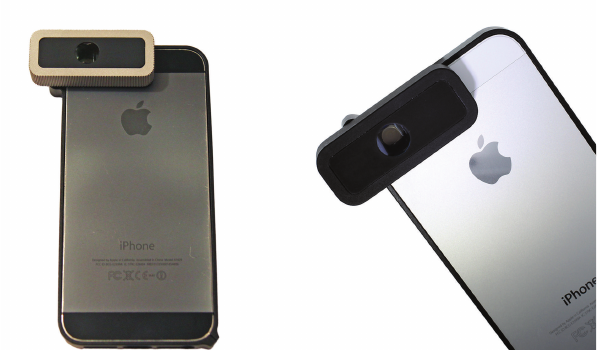
Figure 2: Picture of the prototypes magnetically attached to differ- ent iPhone (5 and 5s; Apple, Cupertino, CA) models.